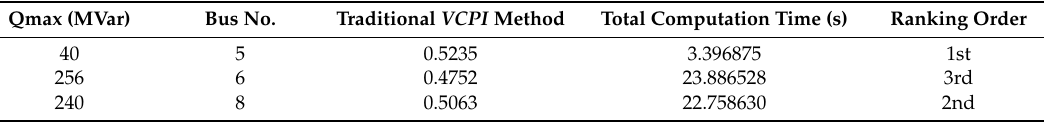
Table 1. Results of the traditional voltage collapse proximity index ( VCPI ) for the 9-bus system. Qmax (MVar) Bus